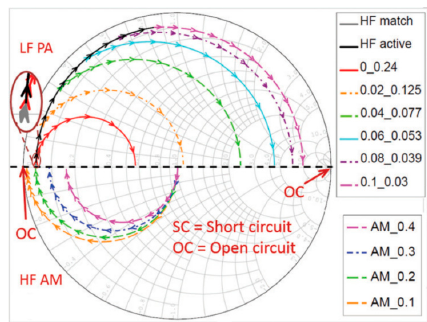
Figure 20. Acoustic filter design calculation using a Smith chart showing the loci of reflection coefficient normalized to the impedance of the piezoelectric material. The numbers followed by AM indicate relative impedance. Reprinted from [190], with the permission of AIP Publishing.